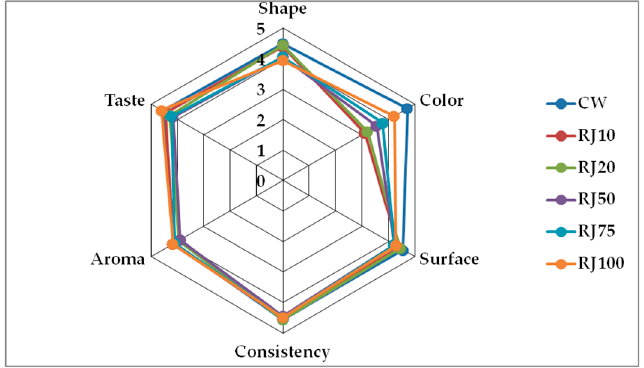
Figure 2. Sensory properties of the analyzed wafers. Table 2. Sensory evaluation of control and fortified wafers, assessed using a five-point hedonic scale (1: bad; 5: very good).